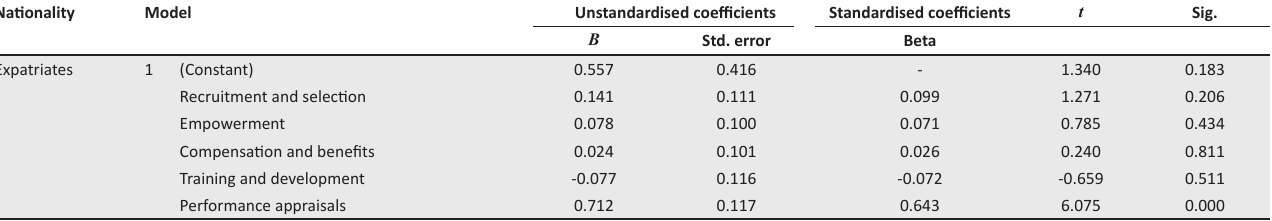
TABLE 5c: Multiple regression results for United Arab Emirates citizens and expatriates.